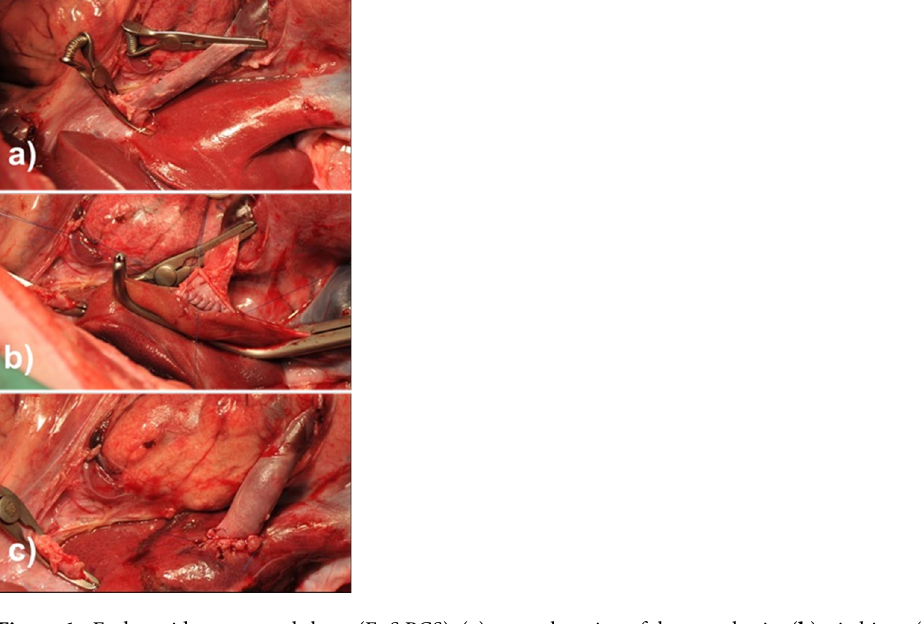
Figure 6. End-to-side portocaval shunt (E–S PCS): ( a ) cross clamping of the portal vein; ( b ) stitching of the posterior wall of the anastomosis; ( c ) complete